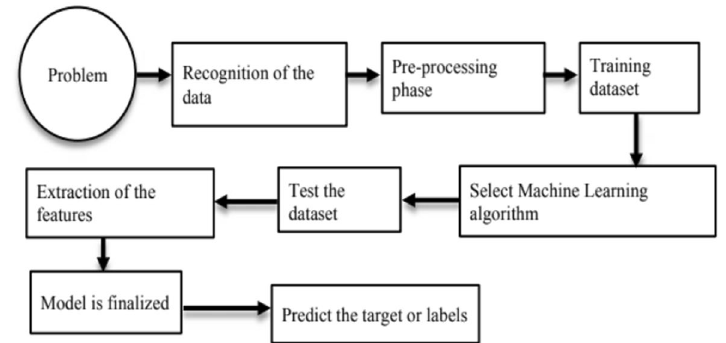
Fig. 8 Unsupervised learning workflow